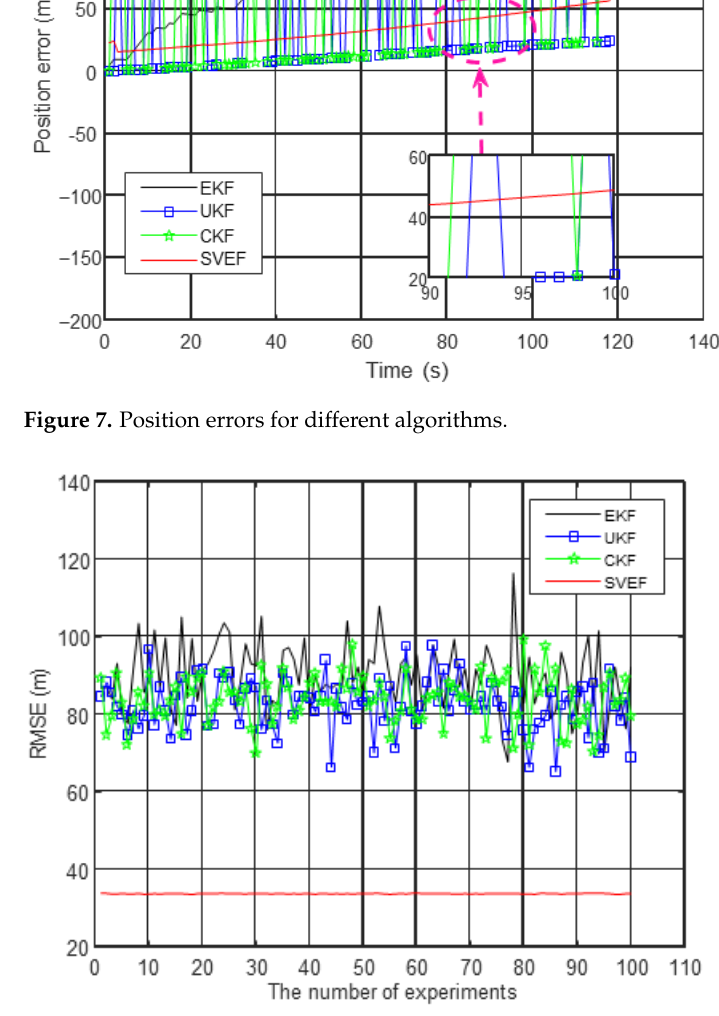
Figure 8. RMSEs for different algorithms.